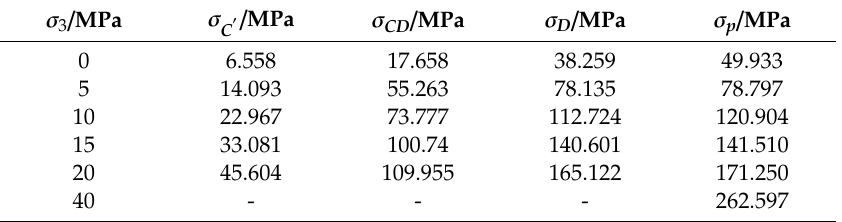
Table 1. Critical stresses during the dilation and the peak stress of sandstone.